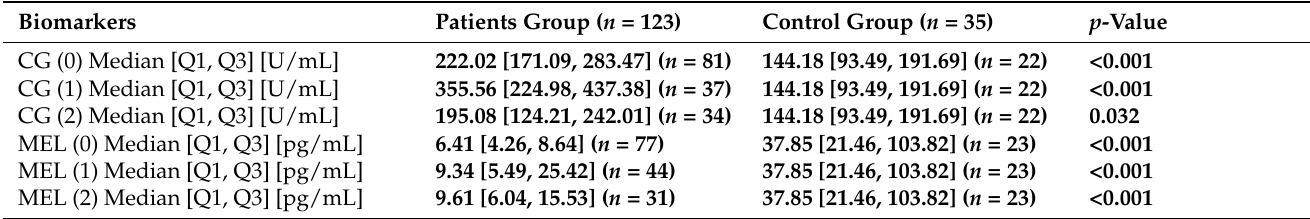
Table 3. The concentration of biomarkers compared to the control group of healthy